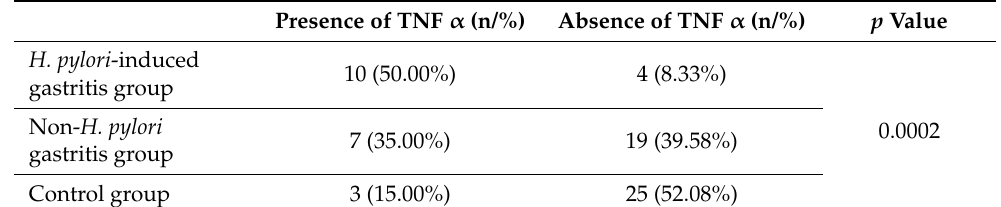
Table 6. The difference of median values of eosinophils between the three groups.